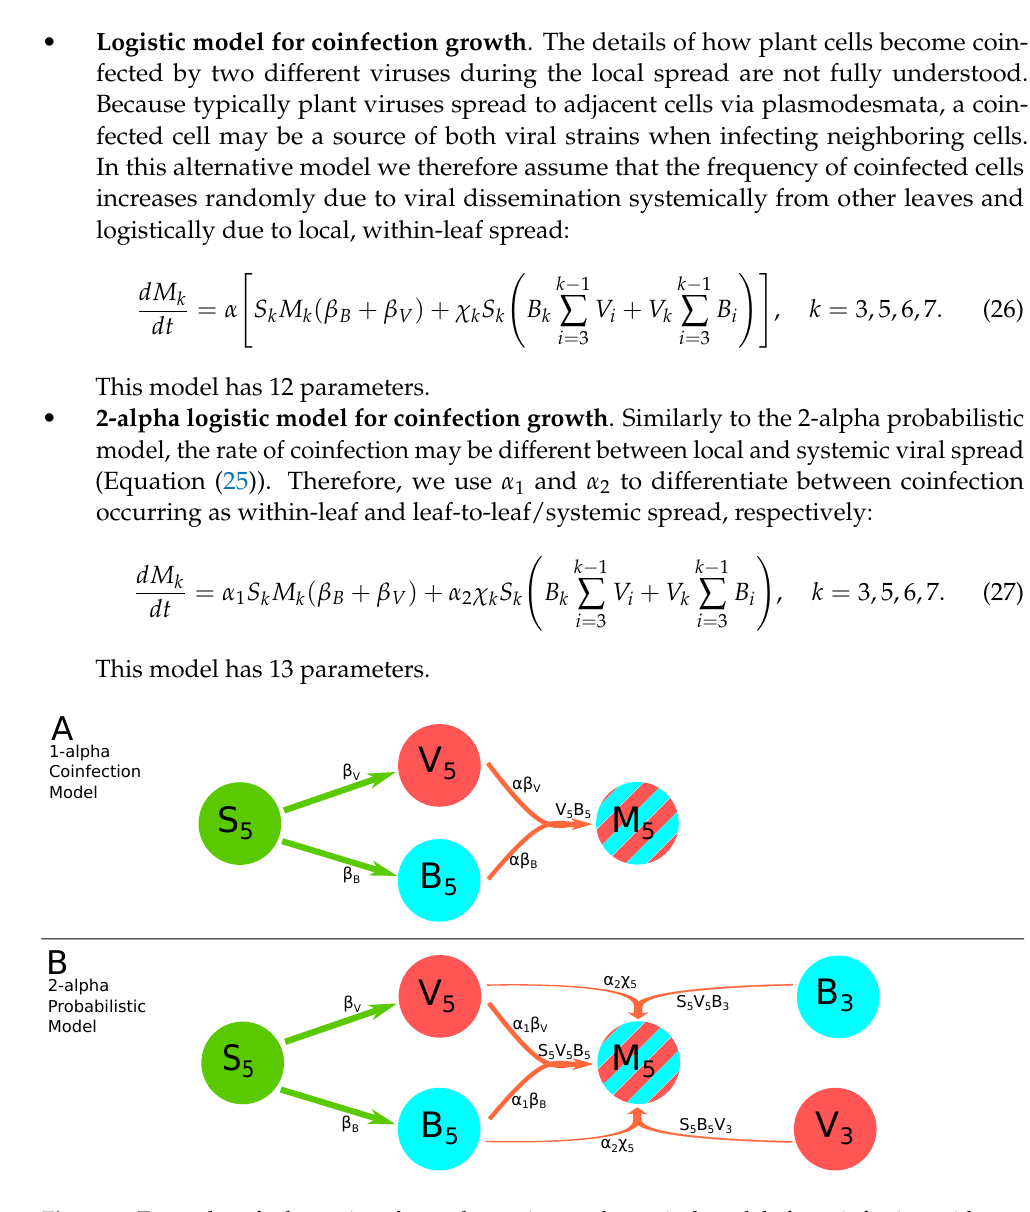
Figure 2. Examples of schematics of two alternative mathematical models for coinfection with two viruses. These diagrams show the infection pathways of infection by TEV-Venus ( V k ) or TEV-BFP ( B k ) in the leaf 5 of the plants, and how these strains combine to form coinfected cells ( M k ) in the 1-alpha coinfection model (( A ), Equation (21)) or 2-alpha probabilistic model (( B ), Equation (25)). Major model parameters such as β and χ k have the same meaning as in the previous models (e.g., Figure 1). We only show what happens in leaf 5 because in the 2-alpha probabilistic model (( B ), Equation (22)), the connections between higher leaves become very complicated and difficult to illustrate in a figure such as this one. Like Figure 1, arrows represent the transmission of virions. In the 1-alpha coinfection Model (( A ), Equation (21)), coinfection comes from the combination of the Venus and BFP viruses within leaf 5 only. In the 2-alpha probabilistic model (( B ), Equation (22)), coinfection comes also from the combination of Venus and BFP virions in leaf five, but is also fed by the combination of virions imported from leaf 3 and combining with their opposite, e.g., Venus from leaf 3 combining with BFP from leaf 5. Two separate alpha terms are used to distinguish dynamics between within-leaf growth and infection from virions imported from lower